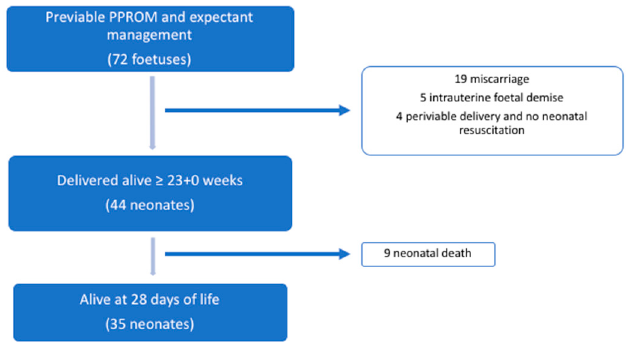
Figure 2. Flowchart of perinatal survival.